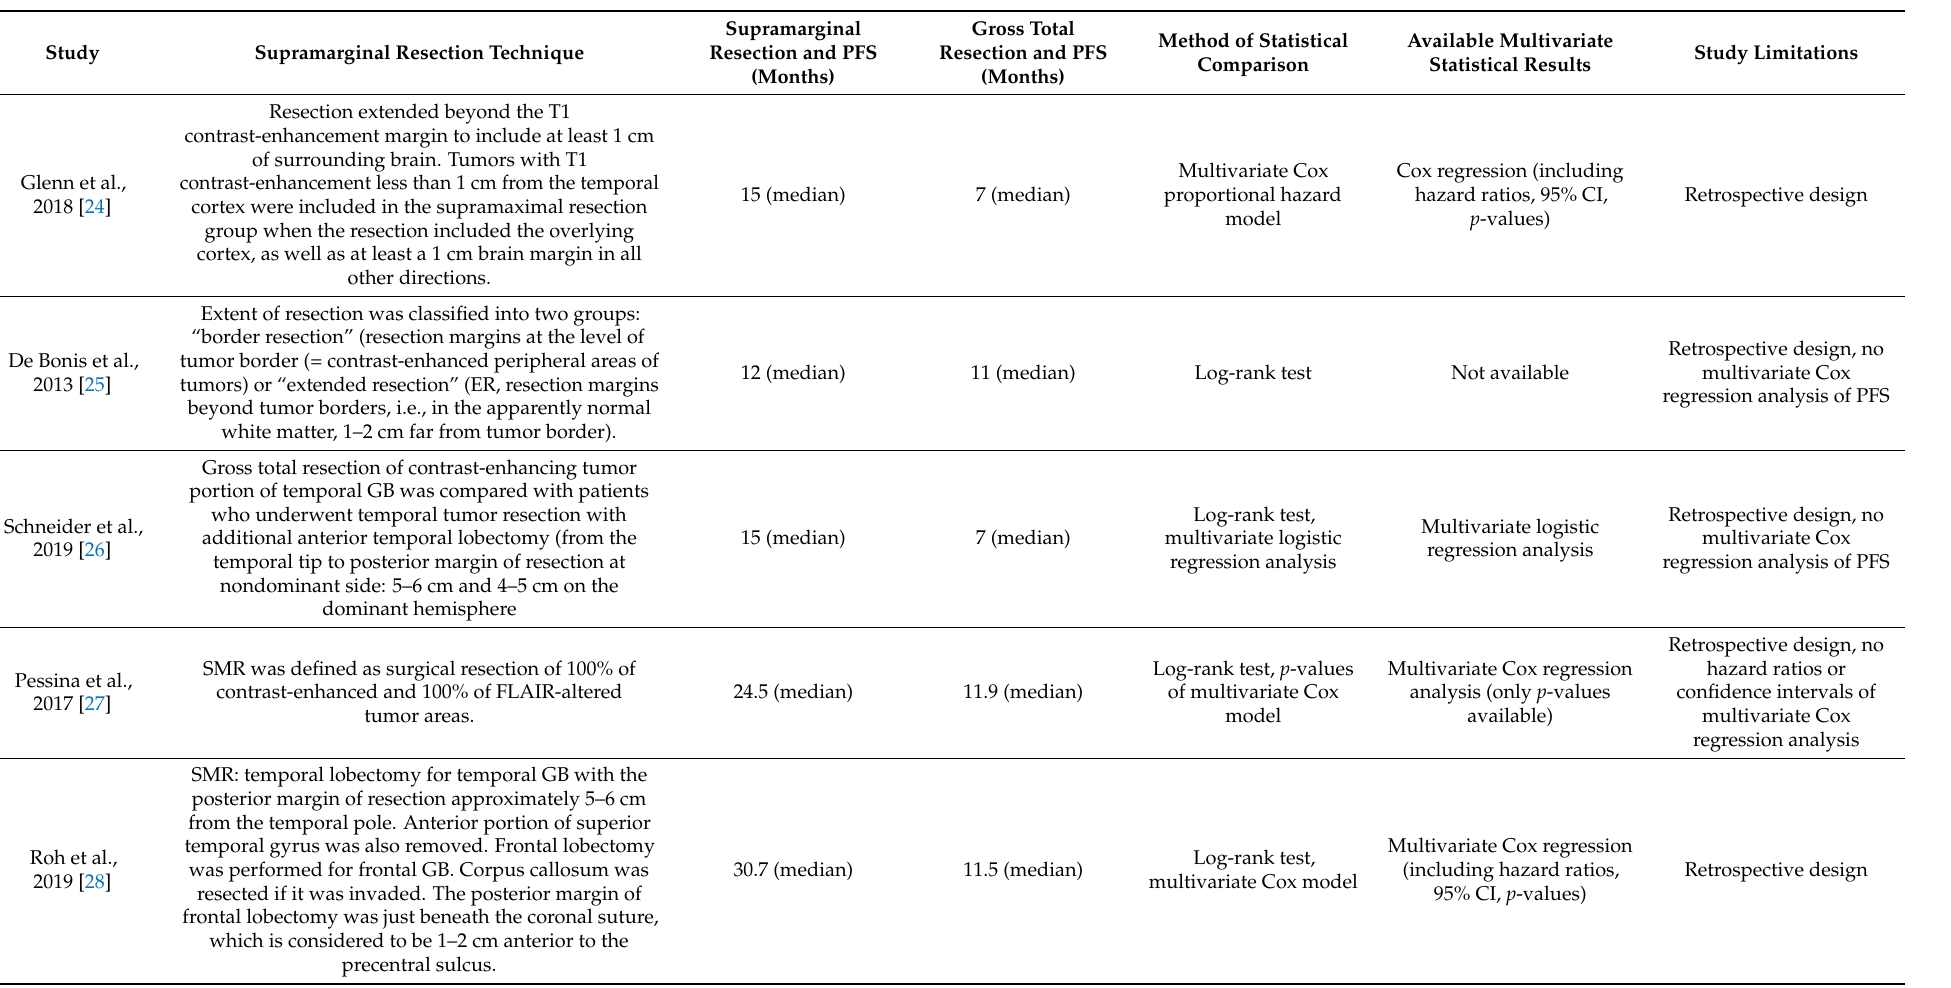
Table 2. Summary of surgical techniques and progression-free survival analyses in studies comparing supramarginal resection and gross total